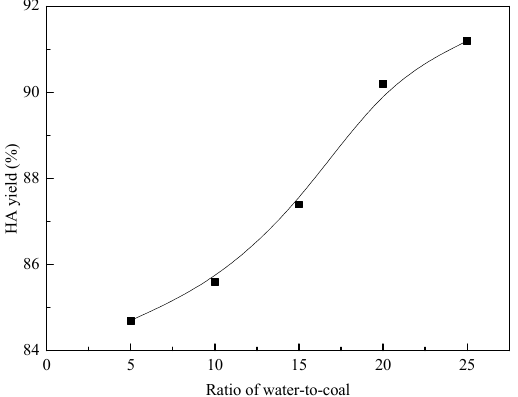
Figure 5. Effect of the water-to-coal mass ratio on the HA yield.